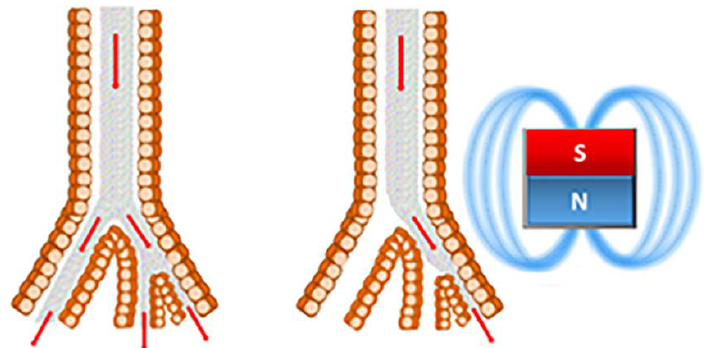
Figure 3. Schematic representation of an MDDS operated under the influence of external magnetic field.